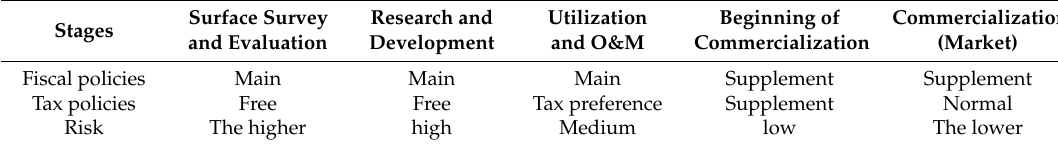
Table 6. Different stages of geothermal industry for fiscal and taxation